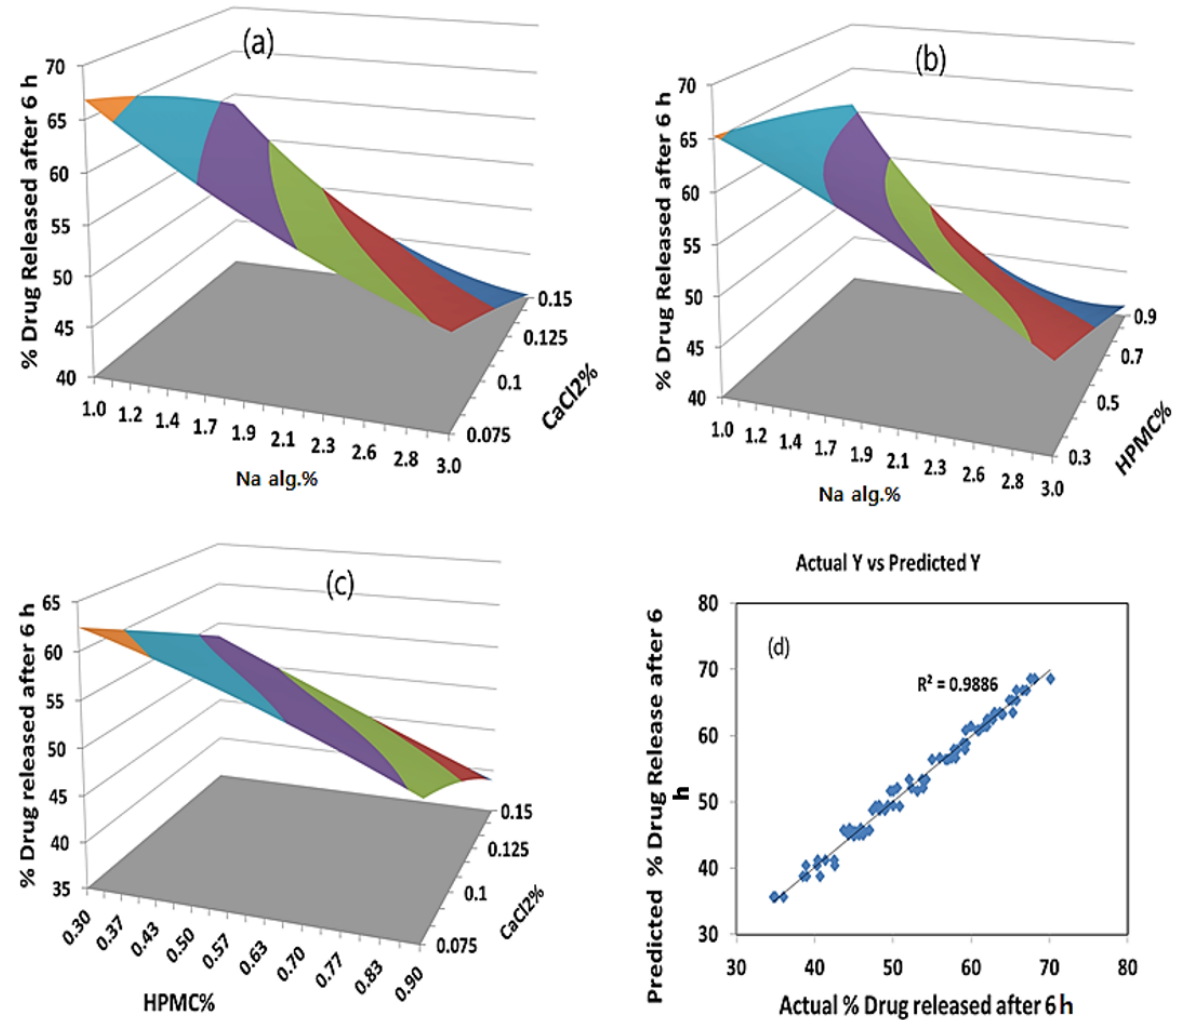
Figure 5. ( a ) Y-hat surface plot showing the effect of X 1 and X 3 on Y 2 at medium level of X 2 ; ( b ) Y- hat surface plot showing the effect of X 1 and X 2 on Y 2 at medium level of X 3 ; ( c ) Y-hat surface plot showing the effect of X 2 and X 3 on Y 2 at medium level of X 1 ; ( d ) linear correlation plot showing predicted against actual values to demonstrate the influence of independent variables X 1 , X 2 , and X 3 on percentage of rug released after 6 h.